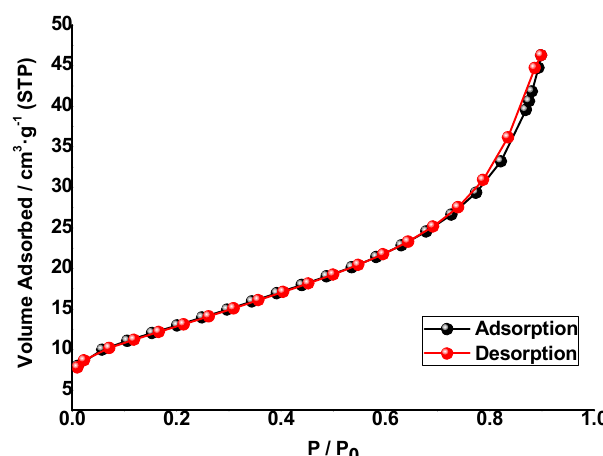
Figure 6. N 2 adsorption–desorption isotherm of Cu(0.1%) / TiO 2 photocatalyst.